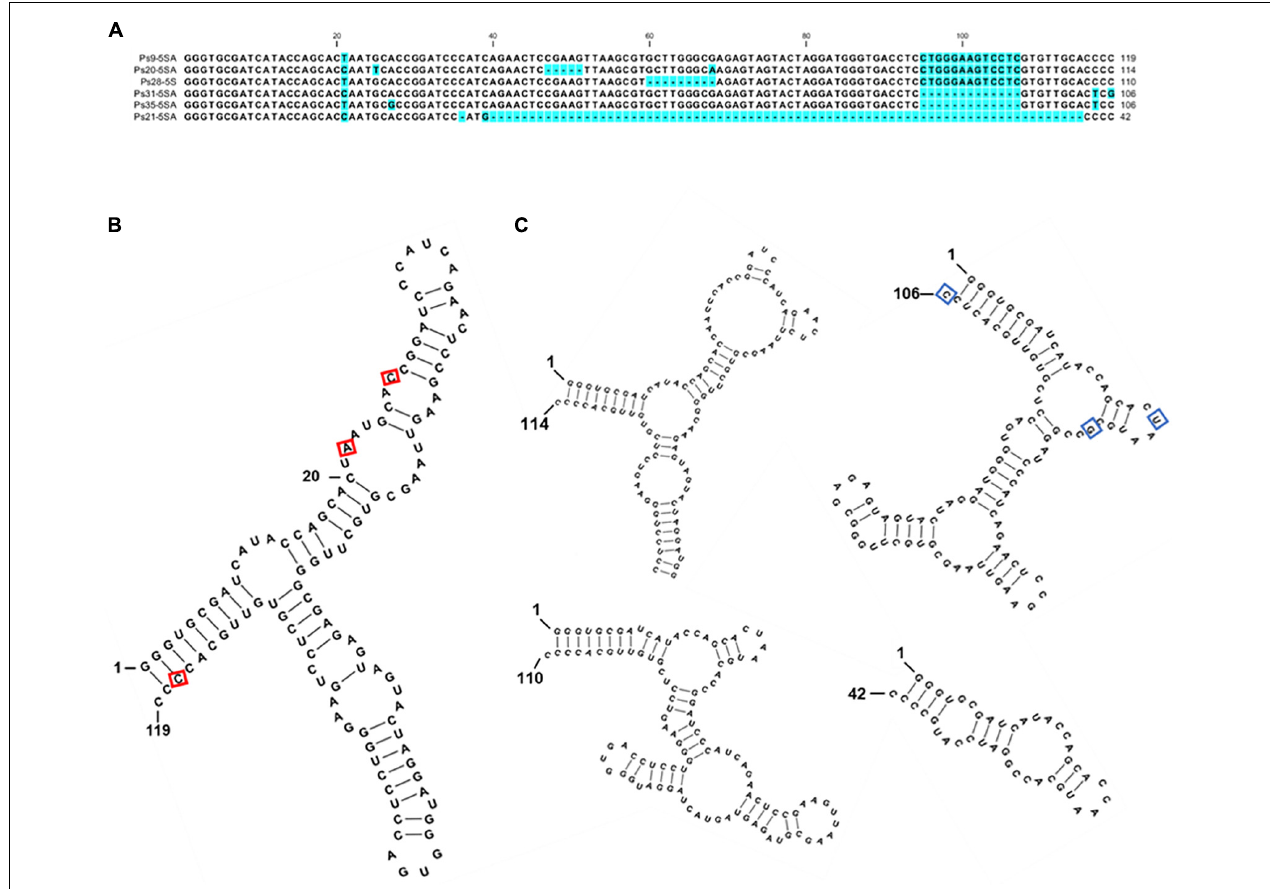
FIGURE 4 | Sequence variants of 5S rDNA identified in the genome of P. stratiotes. (A) Nucleotide alignment of the P. stratiotes 5S rDNA variants. (B) Predicted secondary structure of the full-length 119-nucleotide 5S rRNA. The positions of three nucleotide substitutions occurring at high frequencies are marked with a red rectangle. (C) Secondary structures of the transcripts derived from pseudogene variants 114, 110, 106, and 42 nucleotides long. The 106 nucleotides long pseudogene variant is represented by sequence Ps35-5SA, with the positions of variable nucleotides in clone Ps31-5SA marked by blue rectangles. The free